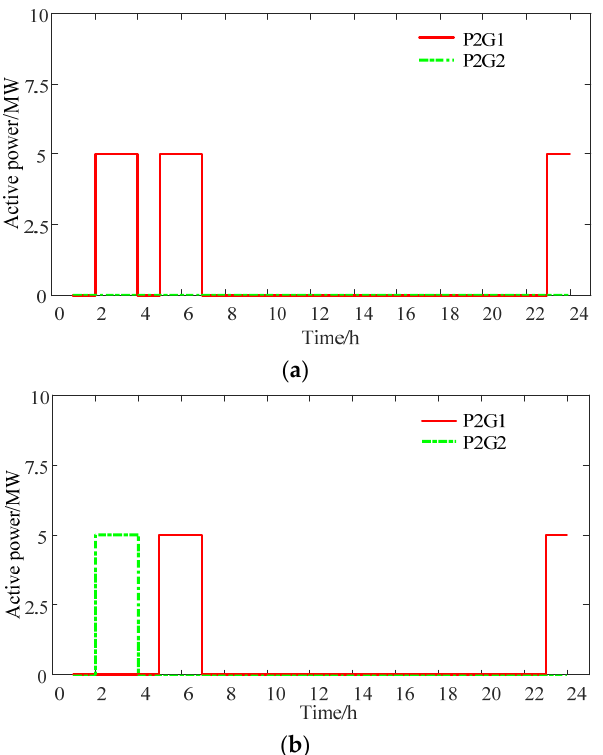
Figure 9. Power converted by P2G facilities in different dispatch modes: ( a ) Separate optimization and ( b ) coordinated optimization.